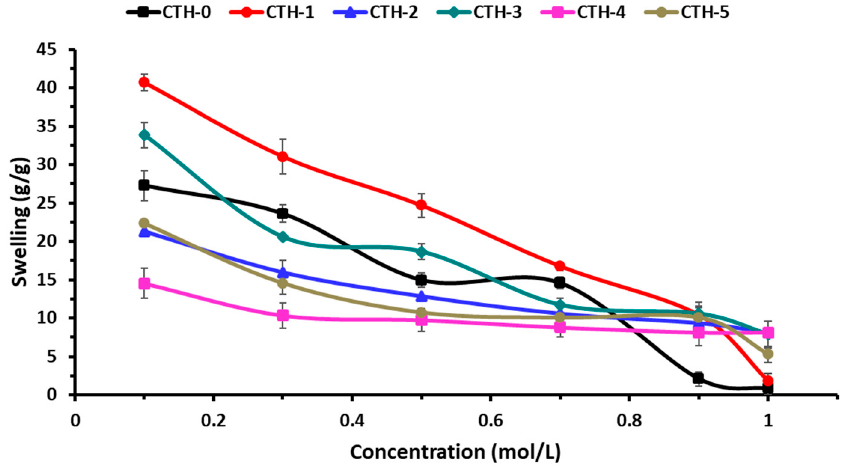
/ PAH films in NaCl solutions of variable molar Figure 7. Swelling behavior of CS/PAH films in NaCl solutions of variable molar concentrations. Figure 7. Swelling behavior of CS